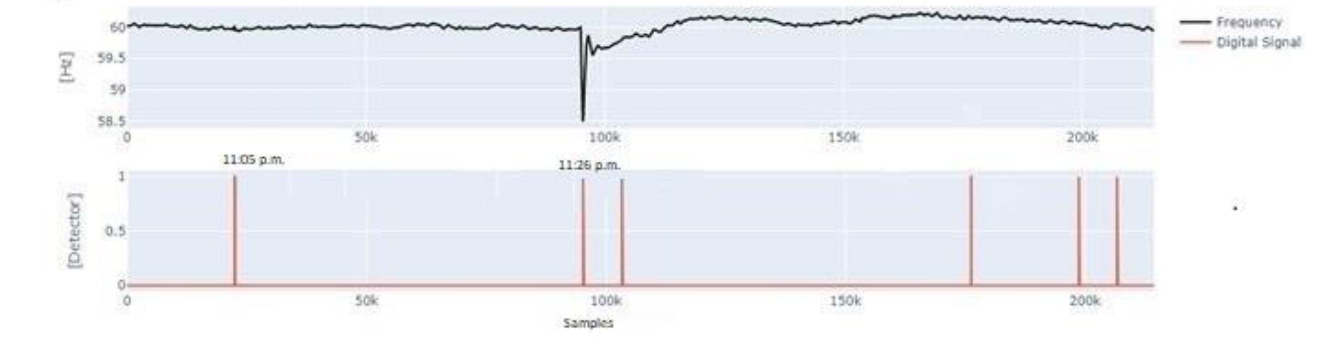
Figure 12. Event 1: final detector.